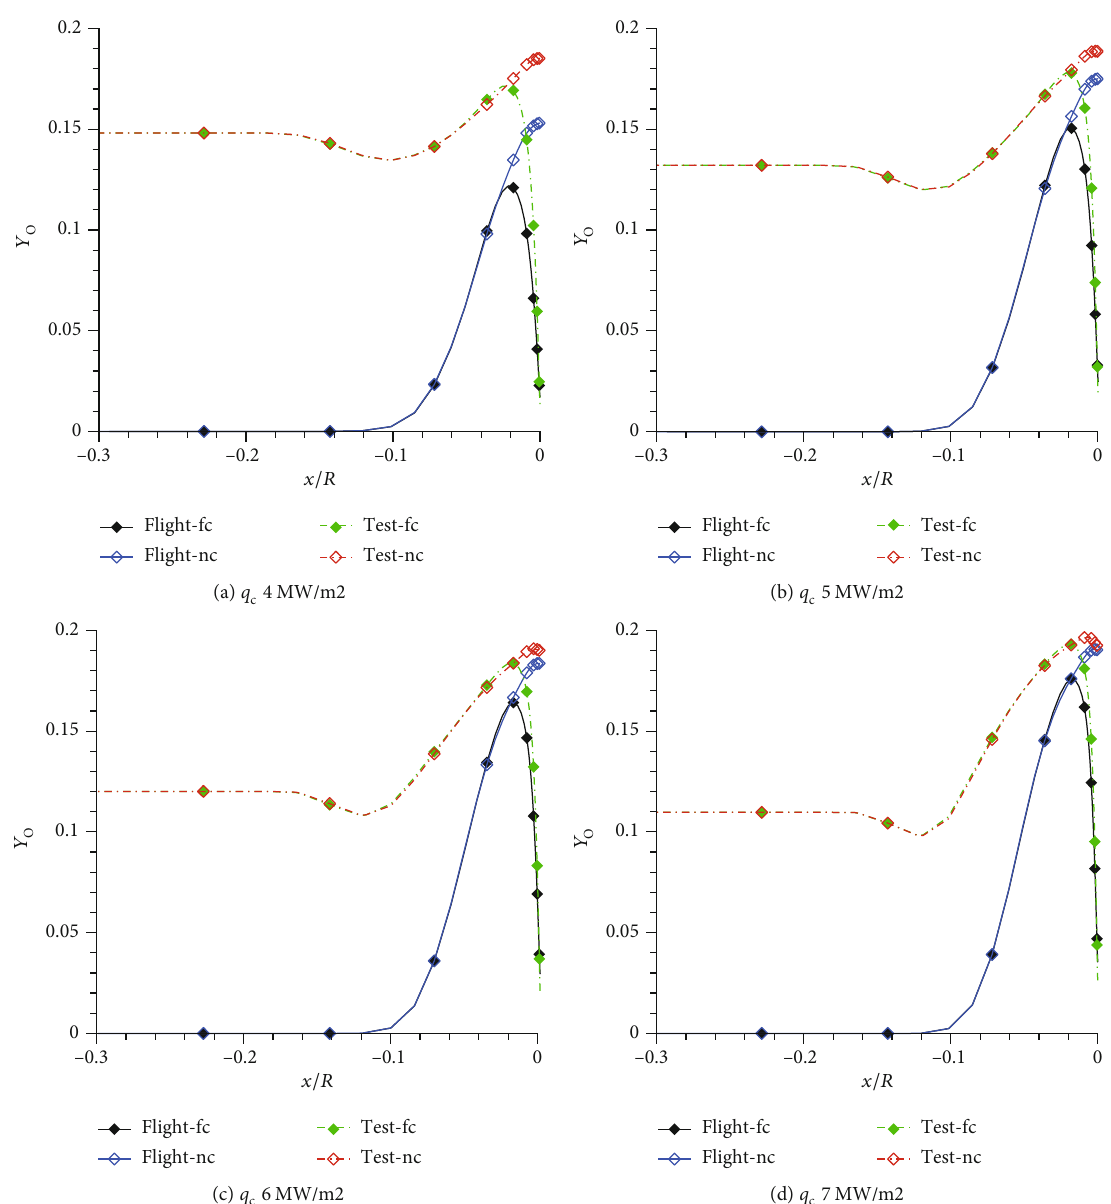
Figure 8: Comparison of oxygen atom mass fractions on the stagnation line for enthalpy 10